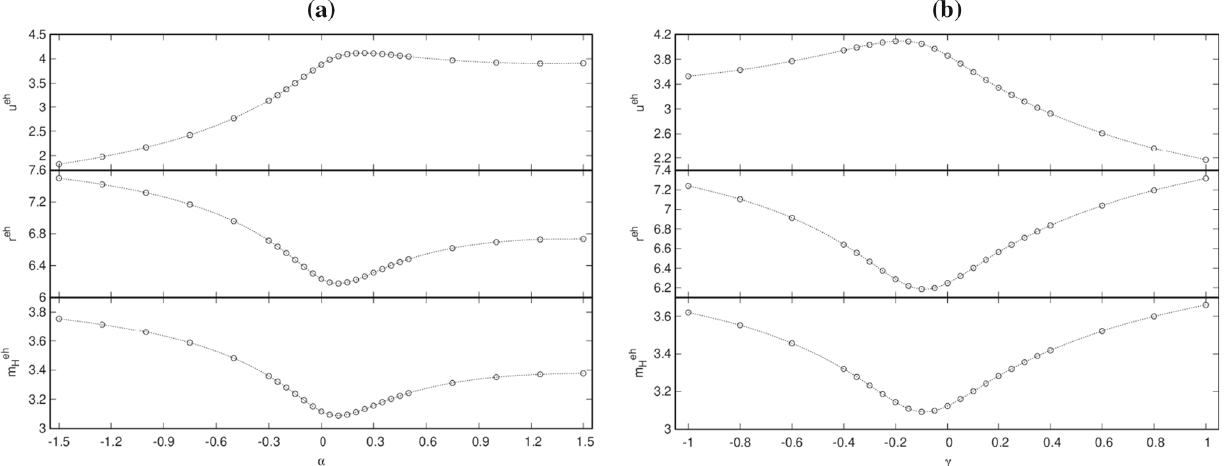
, of black holes formed during the gravitational collapse as functions H